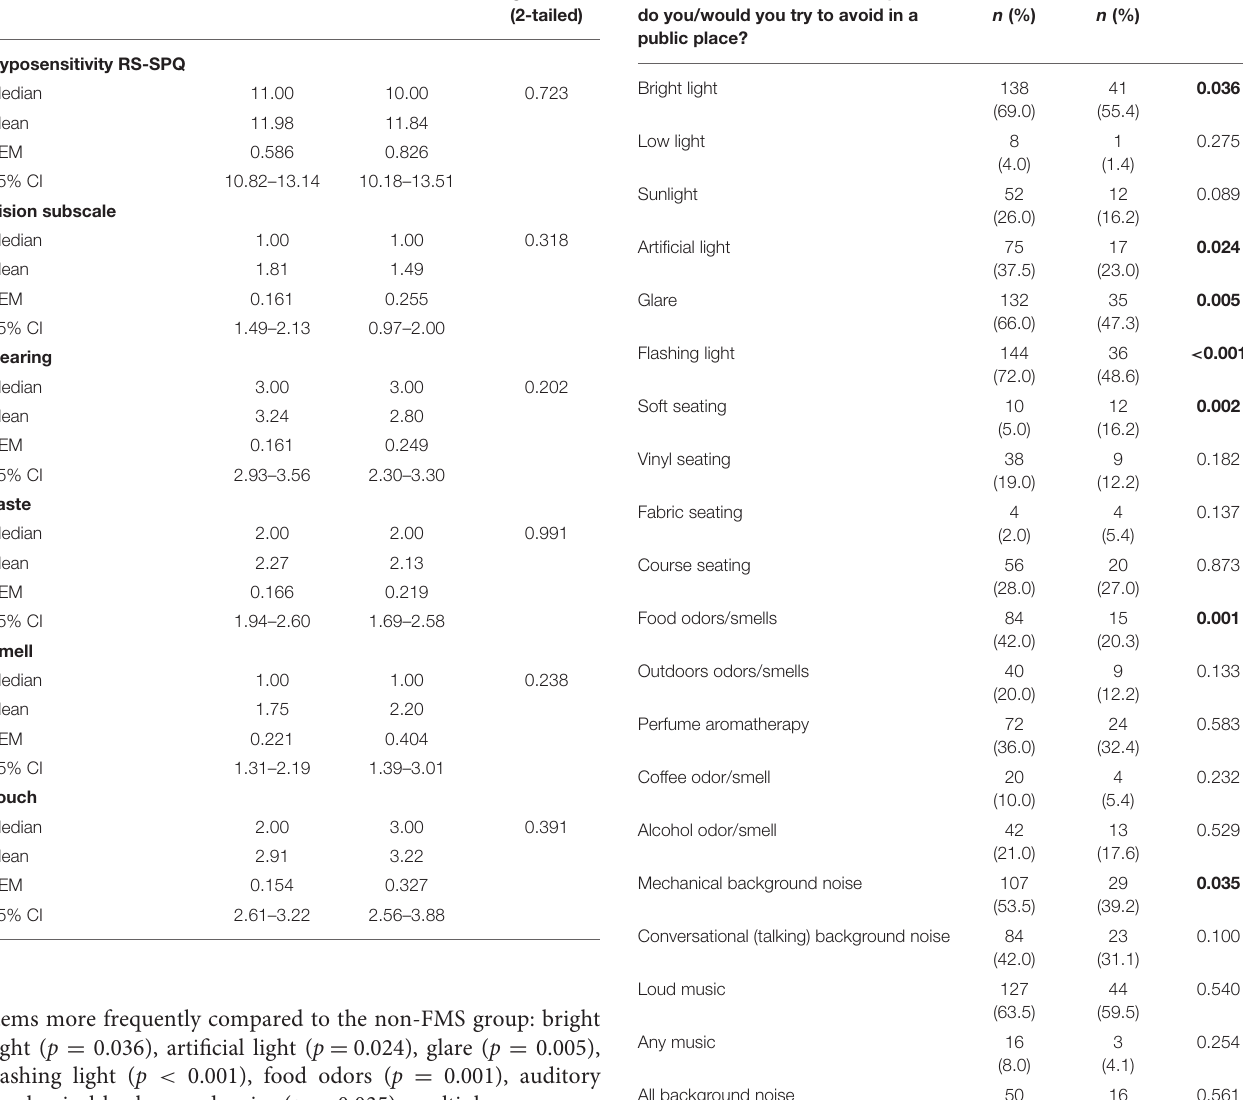
TABLE 4 | Frequency table comparing sensory triggers in the social environment TABLE 3 | Comparison of hyposensitivity between FMS and non-FMS chronic between FMS and non-FMS chronic pain groups. pain groups. FMS Non-FMS Significance Given the choice, what sensory stimuli (2-tailed) do you/would you try to avoid in a public